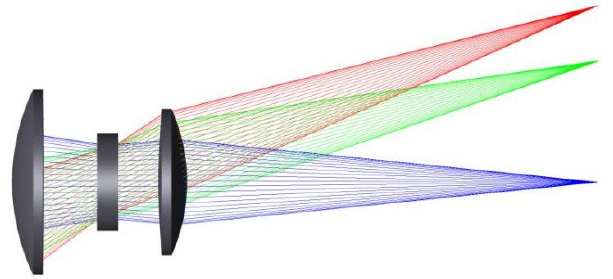
Figure 3. Schematic diagram of Cooke triplet.